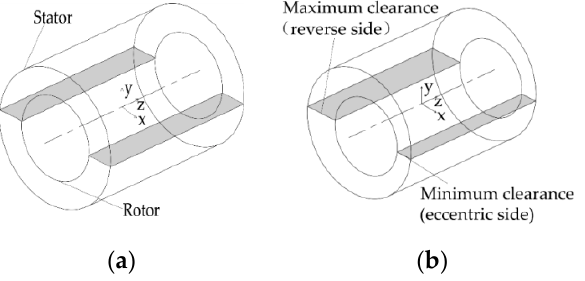
Figure 1. The schematic diagram of the position between the rotor and the stator: ( a ) initial position of the rotor, ( b ) eccentric position of the rotor.